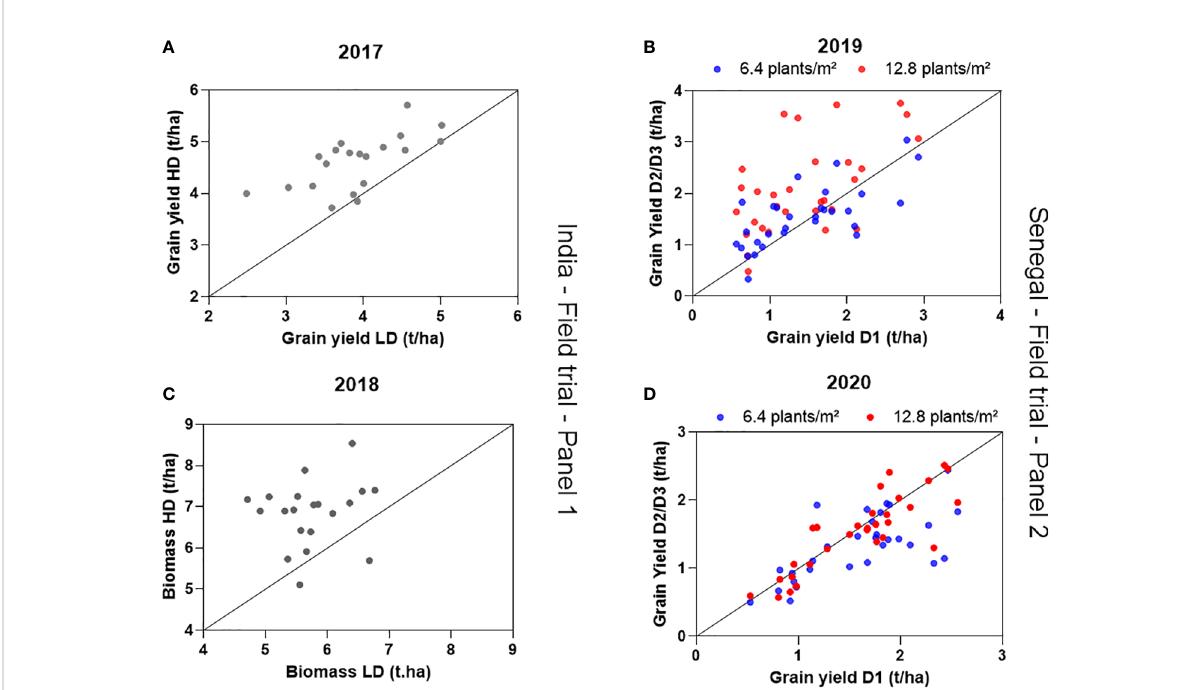
FIGURE 2 Grain yield under high density (HD) as a function of grain yield under low density (LD) in 2017 (A) , total aboveground biomass under high density (HD) as a function of total aboveground biomass under low density (LD) in 2018 (B) in India (A, B) . Grain yield under medium and high density (D2 and D3) as a function of grain yield under low density (D1, 3.2 plants/m 2 )) in 2019 (C) and 2020 (D) in Senegal. Data are means of 4 replicated plots in India and 3 replicated plots in Senegal, for each genotype-by-density